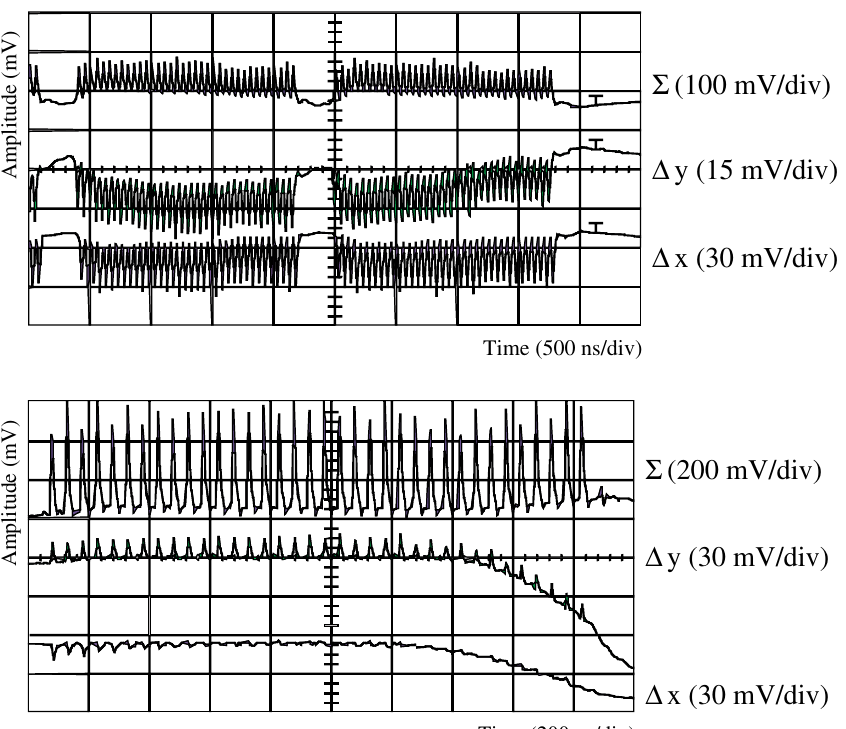
FIG. 4. Measured baseline drift in a PS electrostatic pickup (upper panel) and in TT2 (lower panel) for the 50 ns spacing LHC-type beam. The electron cloud buildup is delayed with respect to the 25 ns case and the drift is also